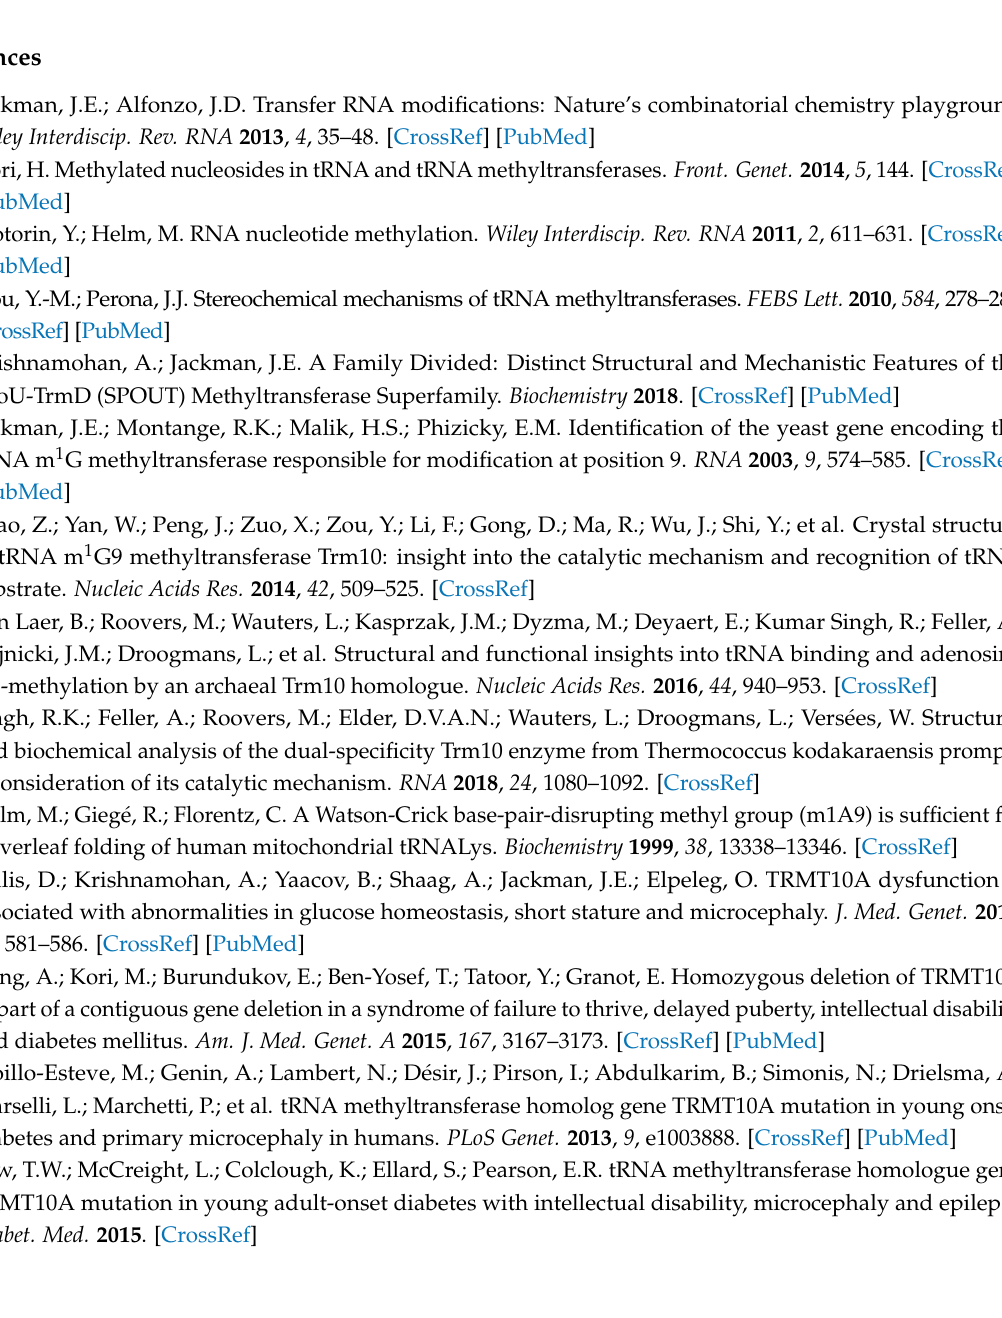
Figure S1: Purified TkTrm10 proteins, Figure S2: pH dependence trends of m 1 G 9 and m 1 A 9 formation by TkTrm10 in native substrates, Figure S3: [Mg 2+ ] dependence of TkTrm10-tRNA binding, Figure S4: Both purine methylation activities of TkTrm10 utilize the same SAM binding site, Figure S5: Location of the TkTrm10 target R 9 in the tRNA